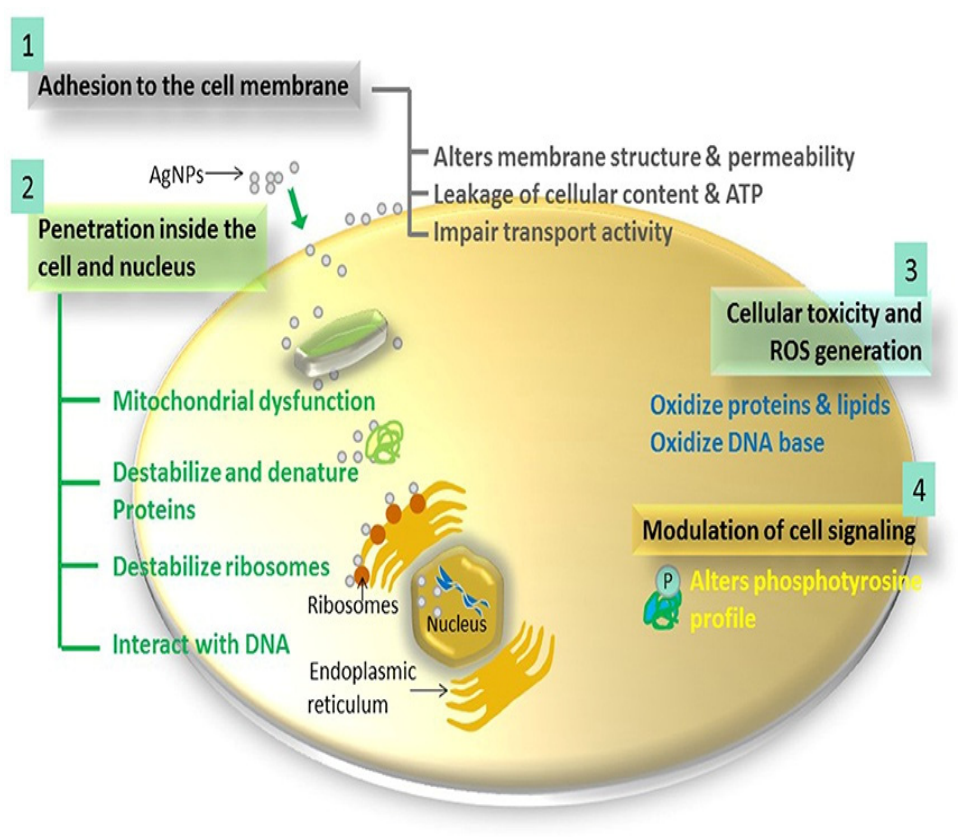
Figure 3. Antibacterial mechanisms of action for AgNPs. Interaction of the AgNPs with the bacterial cell membrane cause damage to the cell membrane and increases membrane permeability ( 1 ), AgNPs are internalized by the bacteria and interact with cellular organelles and biomolecules ( 2 ), AgNPs increases ROS production ( 3 ), and modulate cellular signals leading to cell death ( 4 ). Reprinted with permission from Ref. [137]. Copyright 2016, Frontiers.